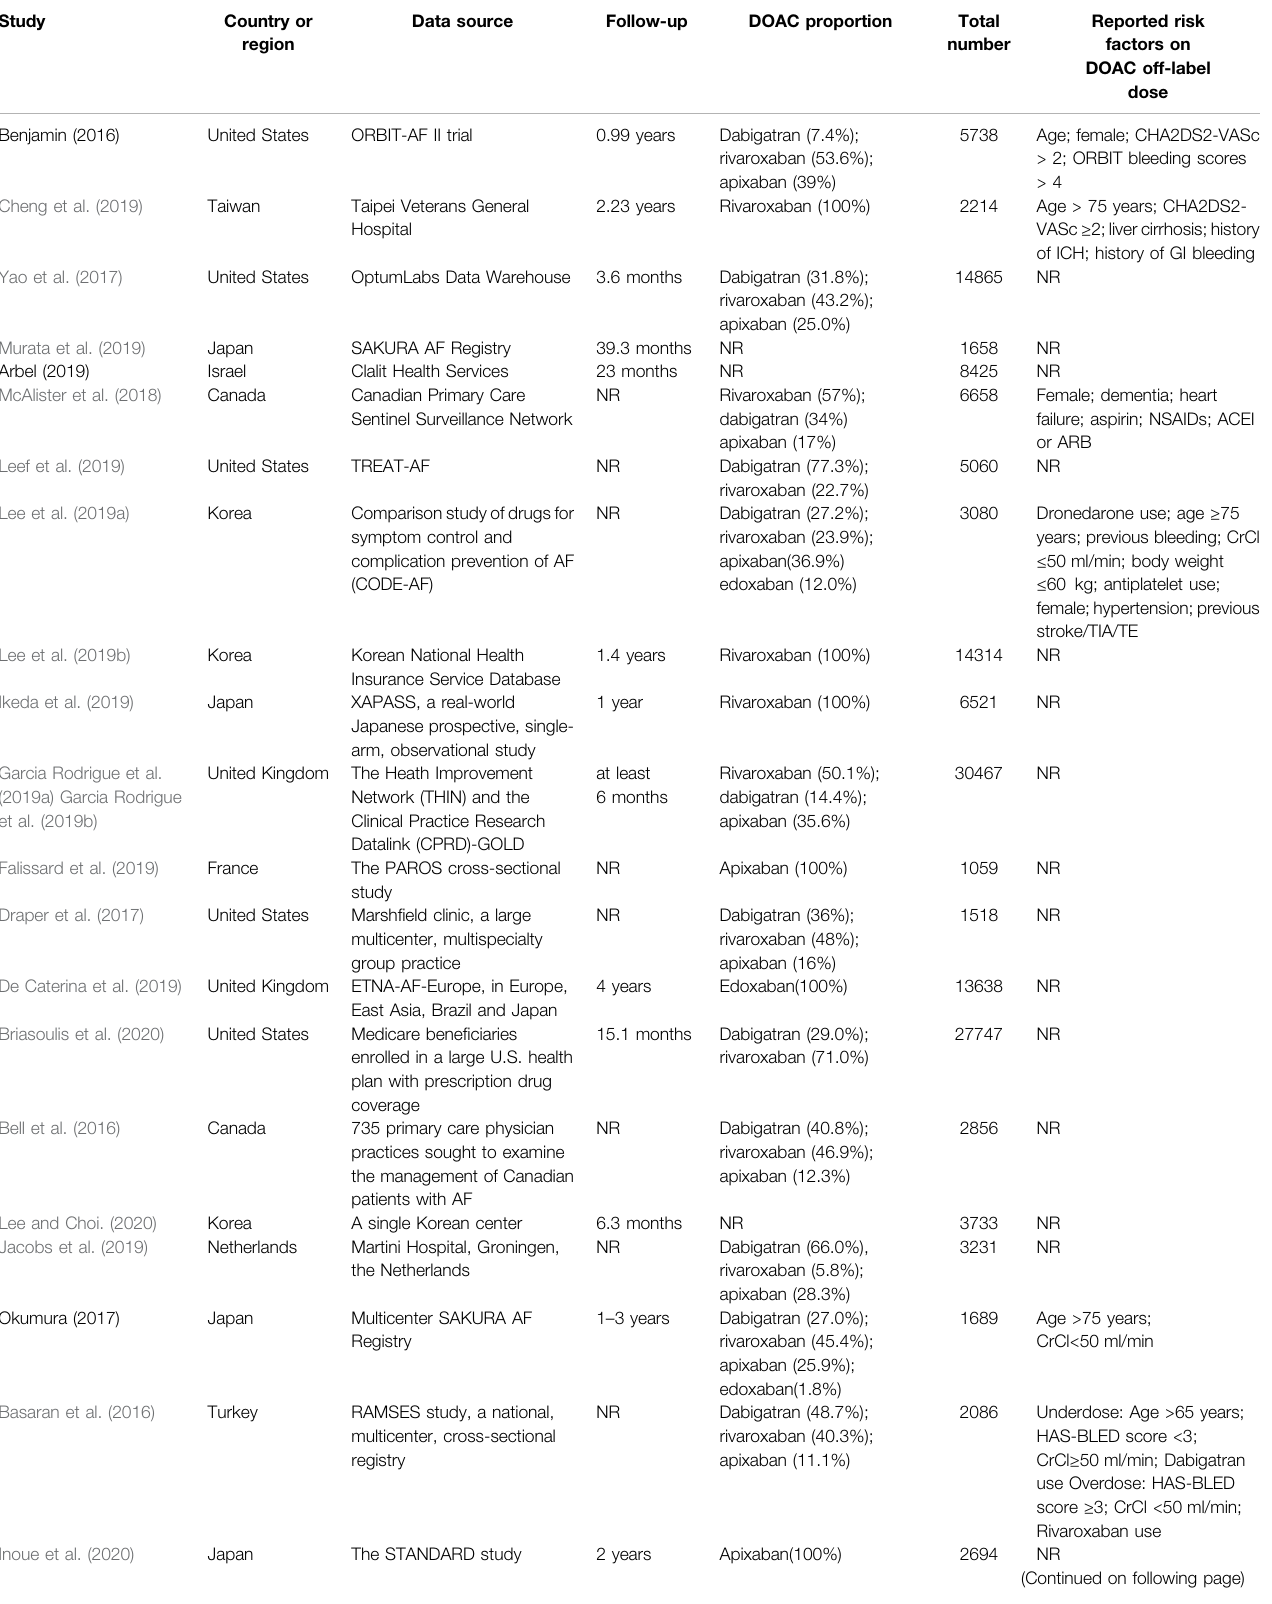
TABLE 2 | Detailed characteristics of the included